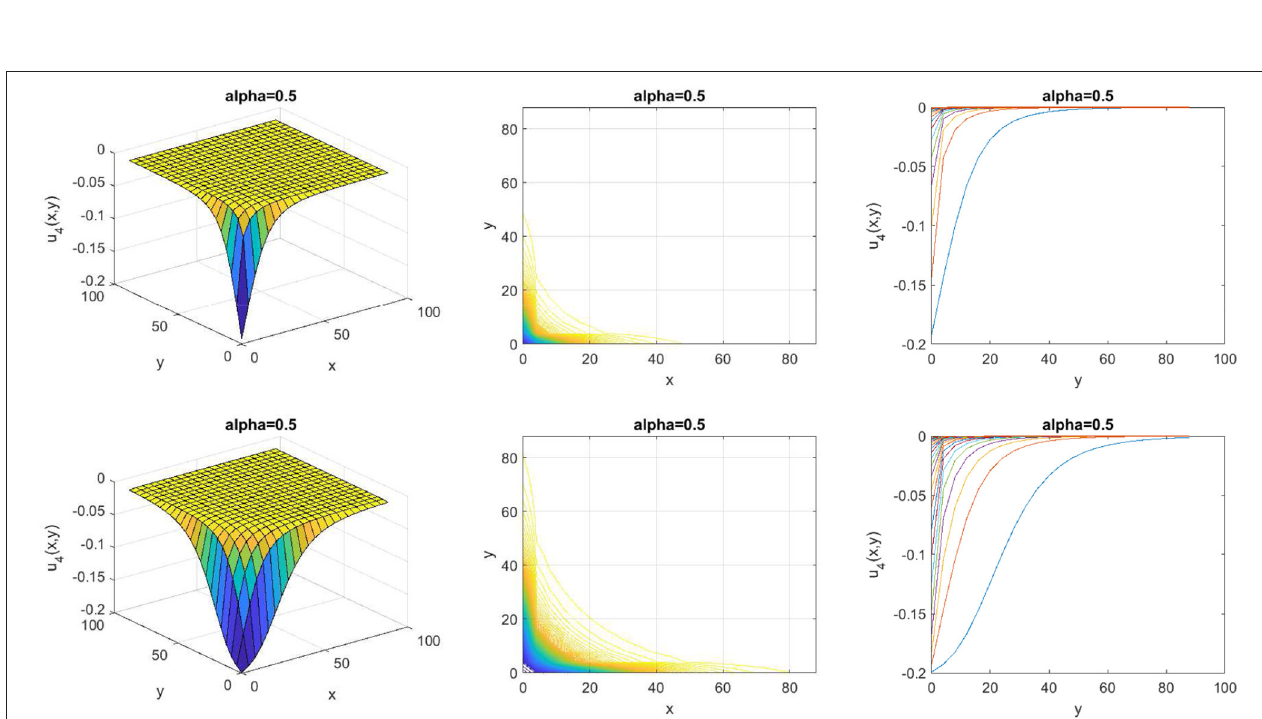
FIGURE 3 | Kink wave solution of Equation (36) in 3D, contour and 2D for Case I.